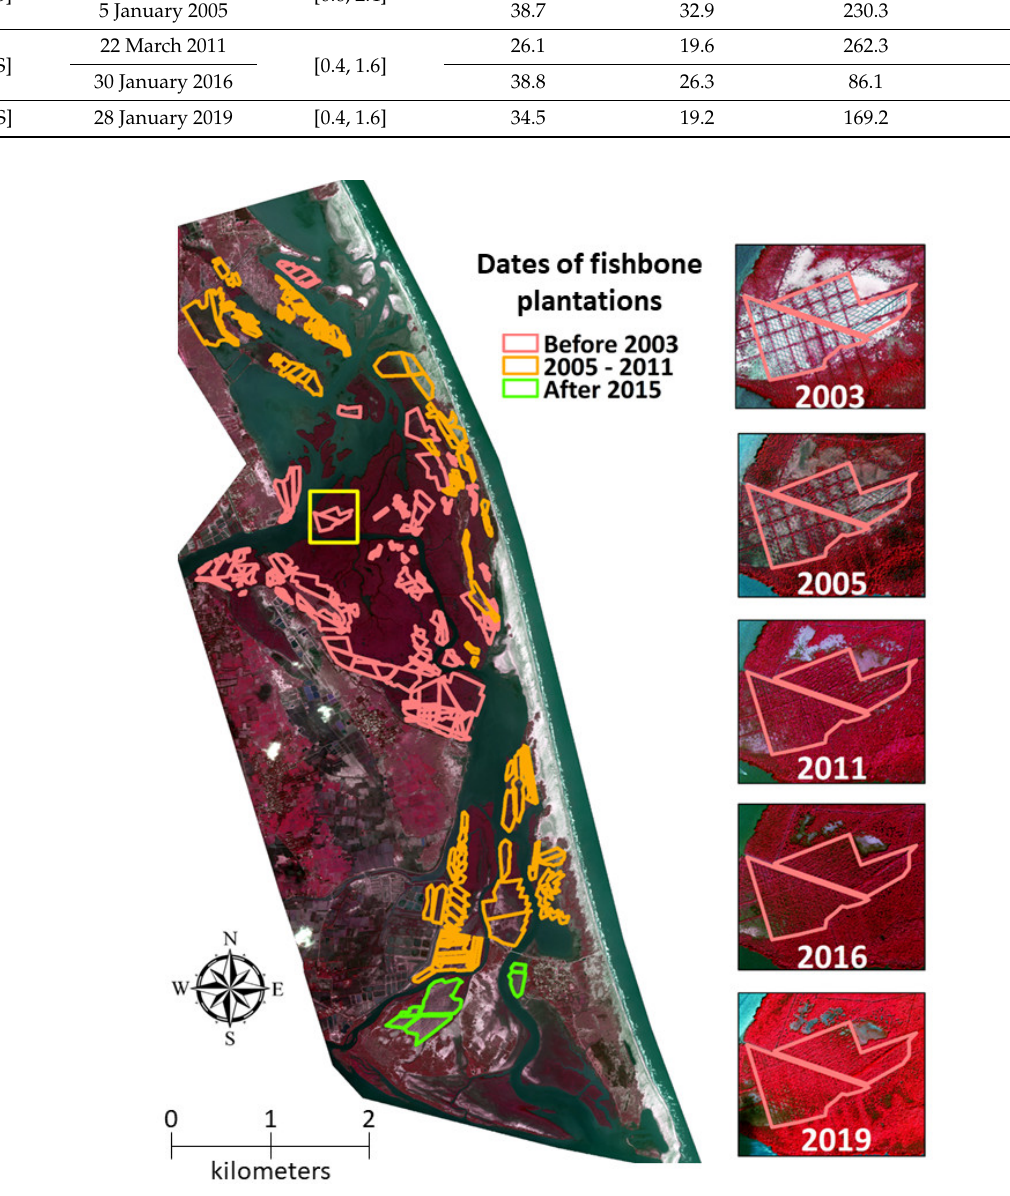
Figure 3. Pichavaram mangroves in Tamil Nadu along with the locations of the fishbone plots (left). Changes in the mangrove cover inside a 400 × 400 m fishbone plot (yellow square) implemented before 2003 are illustrated on the right using the VHSR image dataset described in Table 1.